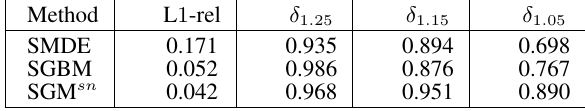
Table 2. Comparison of the presented SMDE approach to two variants of the SGM algorithm that perform depth estimation by epipolar geometry, namely SGM sn from (Ruf et al., 2019) and SGBM from